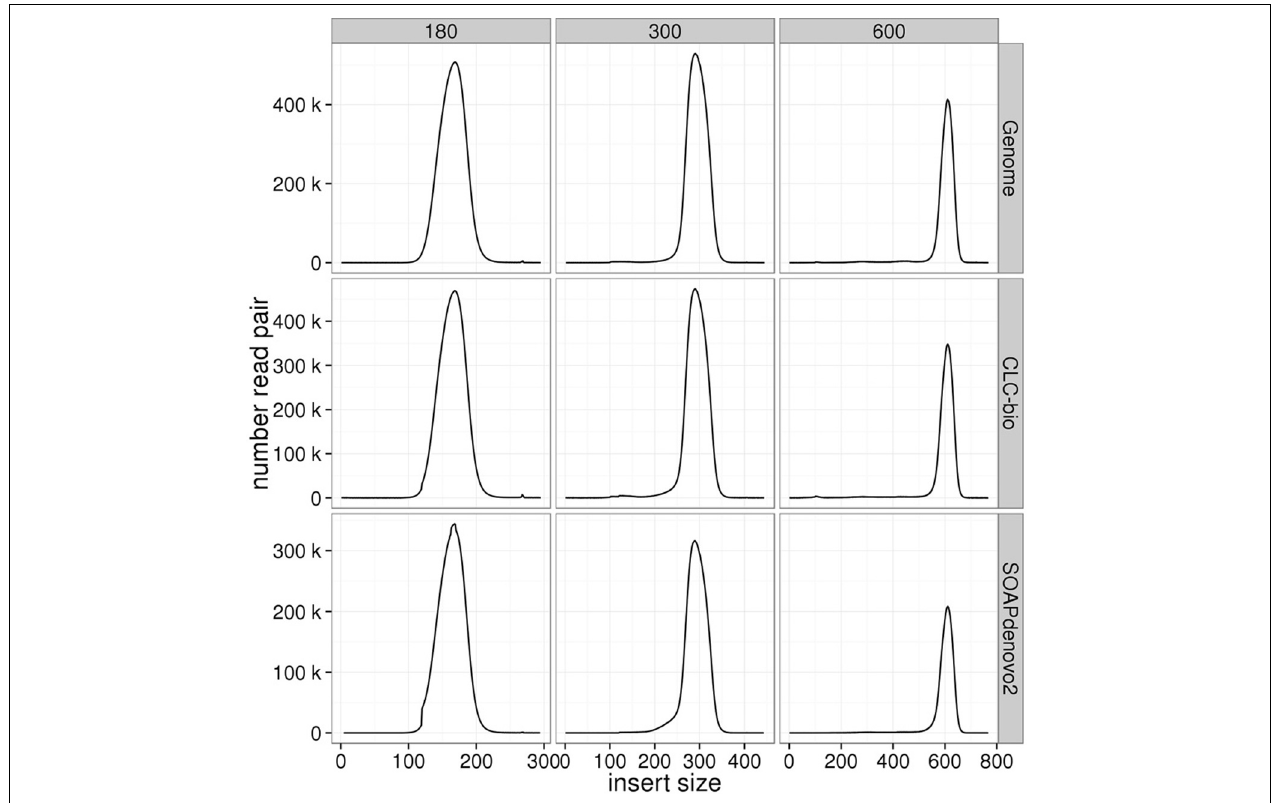
FIGURE 4 | Estimation of insert sizes for A. thaliana paired-end genomic libraries. Insert sizes are plotted for each target size using reads mapped against the A. thaliana reference genome, CLC, and SOAPdenovo2